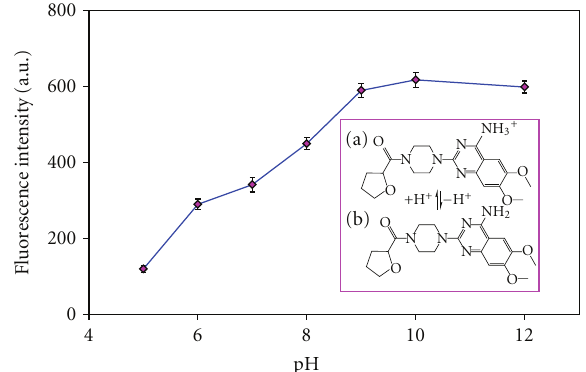
Figure 4: Influence of pH on the fluorescence intensities. Exper- imental conditions: terazosin concentration 75 μ g L − 1 ; [Hpy][PF 6 ] 150 mg; NaPF 6 350 mg. Inset: chemical structure of terazosin. Acid base equilibrium involved at working pH. (a) Protonated form of this terazosin; (b) dissociated form of